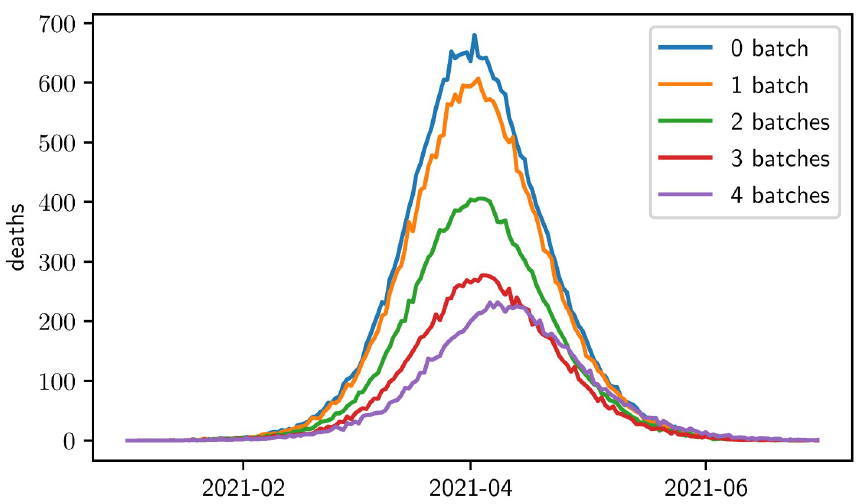
Fig 2. Model results for daily COVID-19 caused deaths after every step of the iterative optimization algorithm. In each step, one additional batch has been distributed. The target variable for the optimization algorithm is the number of cumulative COVID-19 caused